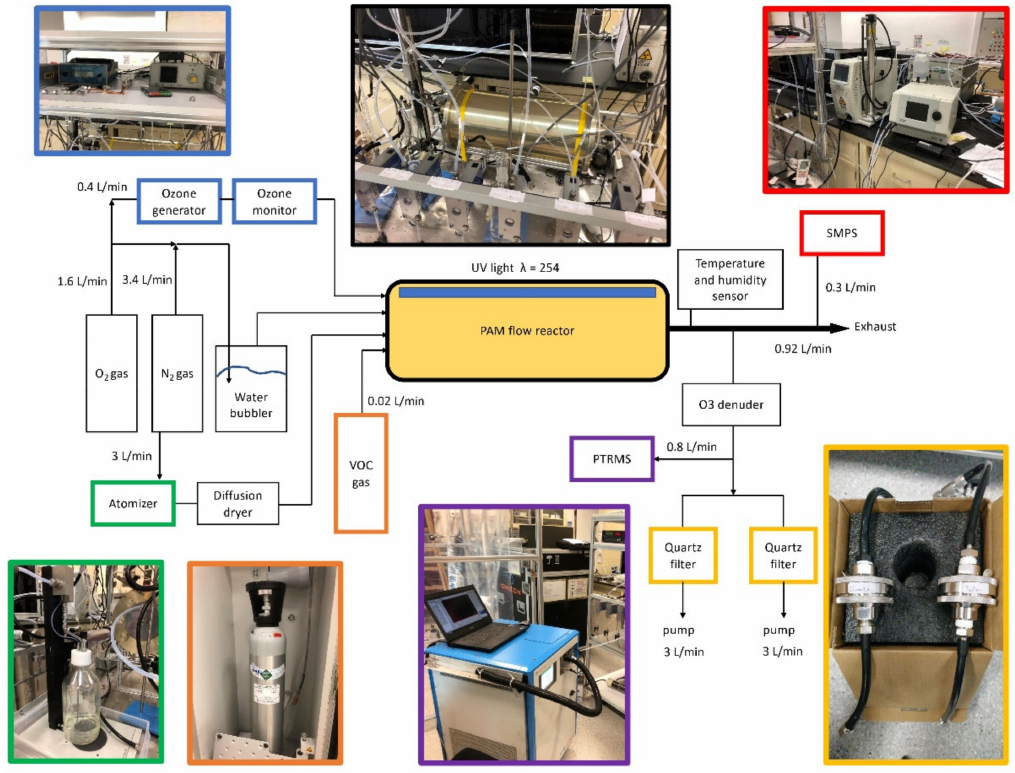
Figure 1. Schematic diagram of the instrumental setup. To study the gas phase products generated in PAM OFR, a proton transfer reaction- mass spectrometer (PTR-QMS 300, IONICON ANALYTIK GES.M.B.H., Innsbruck, Austria) was connected to the outlet of the reactor. The PTR-MS was run in scan mode to record all peaks from 21 to 250 m / z with resolution of 1 amu. To check if the PTR-MS was capturing the right m / z , the presence of peaks at m / z = 30 (NO + ion) and m / z = 93 (toluene ion) were checked before and after the injection of toluene respectively. Particle number and mass concentration at the outlet of the PAM OFR was monitored by a scanning mobility particle sizer (SMPS, TSI, Shoreview, MN, USA). One set of SOA sample was collected for off-line GC/MS analysis. These samples were collected on five quartz filters (47 mm, Global Life Sciences Solutions USA LLC, Marlborough, MA, Whatman, USA) under the same experimental conditions (OH exposure = 1.4 × 10 12 molec cm − 3 s and in the presence of (NH 4 ) 2 SO 4 seed). The sample collection time for each filter was around 6 h, and an average of 1.6 mg of SOA sample was collected on each filter. An ozone denuder was installed before the filter to prevent prolonged oxidation of SOA sample on the filter